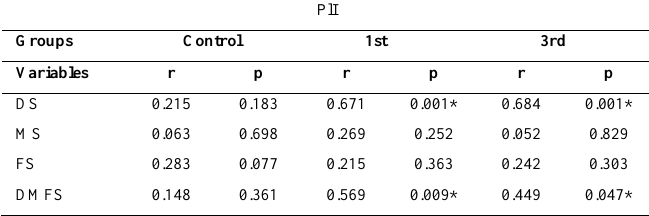
Table 4: Correlation between caries experience by surfaces and teeth with PlI among groups